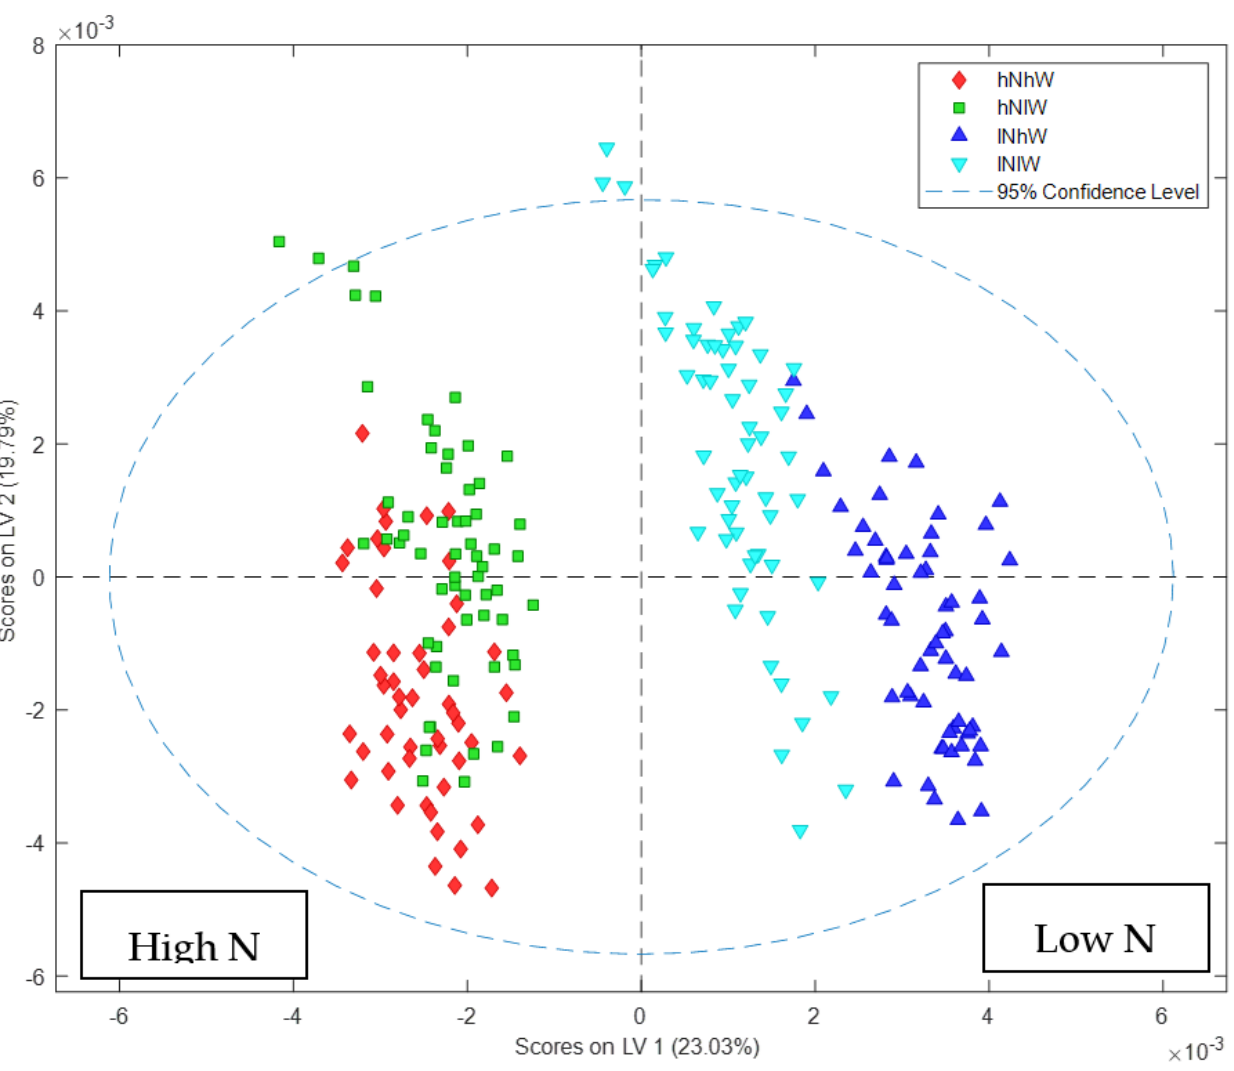
Figure 6. PLS-DA score plot of 1 H NMR data showing major effect of nitrogen on Carmel hull samples with significant water treatment influence on low N samples. Error of classification on cross validation: high N high W 10%, high N low W 14%, low N low W 10%, low N high W